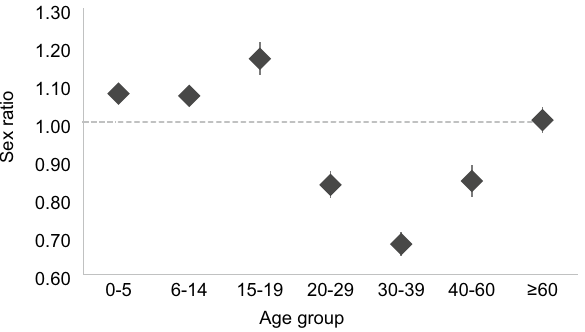
Figure 5. Sex ratio of the influenza prevalence rate by age group. Average female-to-male ratio in the influenza prevalence rate in each age